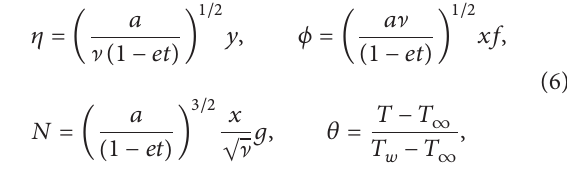
𝑏 is a constant and has dimensions